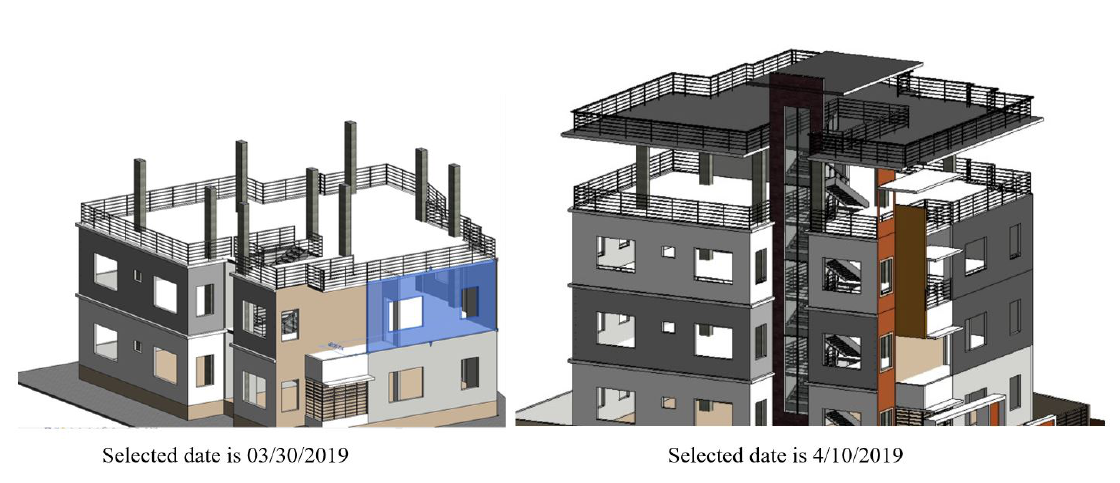
Figure 12. Automatic placing TSF by date.